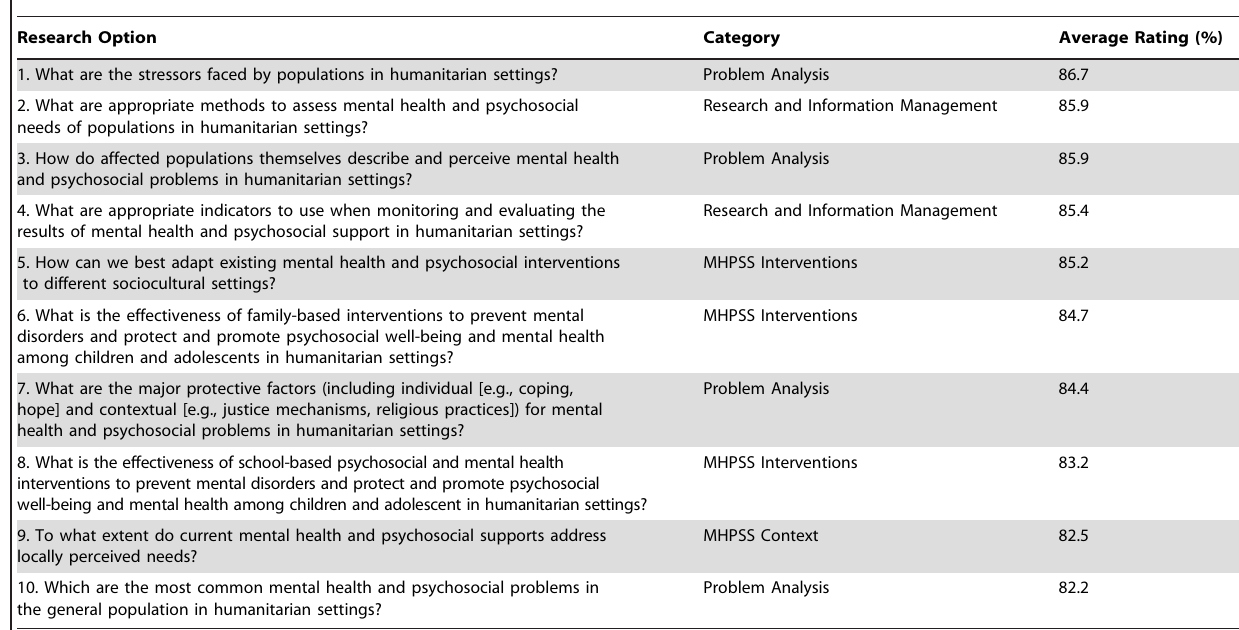
Table 1. Ten most highly endorsed research